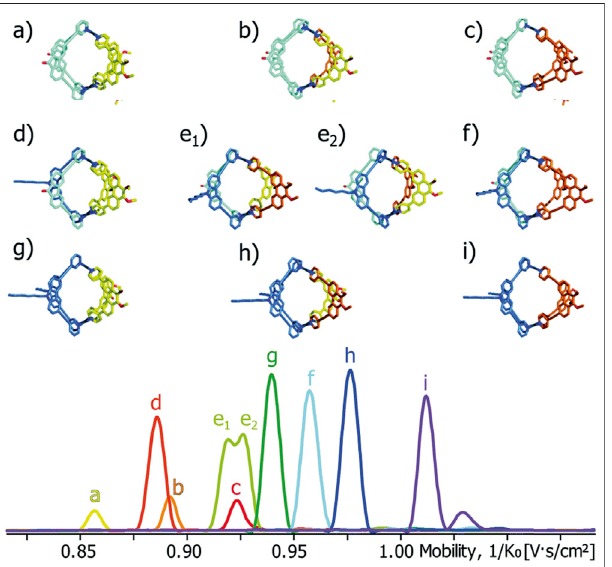
FIGURE9| HeterolepticPalladiumcages (A – F) separatedbyTIMS.The cages observed represent the observed self-assembly products of four bis- pyridine ligands with similar structures. Note that these cages could all be identi fi edbymassdifferences,except cis / trans isomerse 1 ande 2 ,which were only separated and identi fi ed by TIMS.